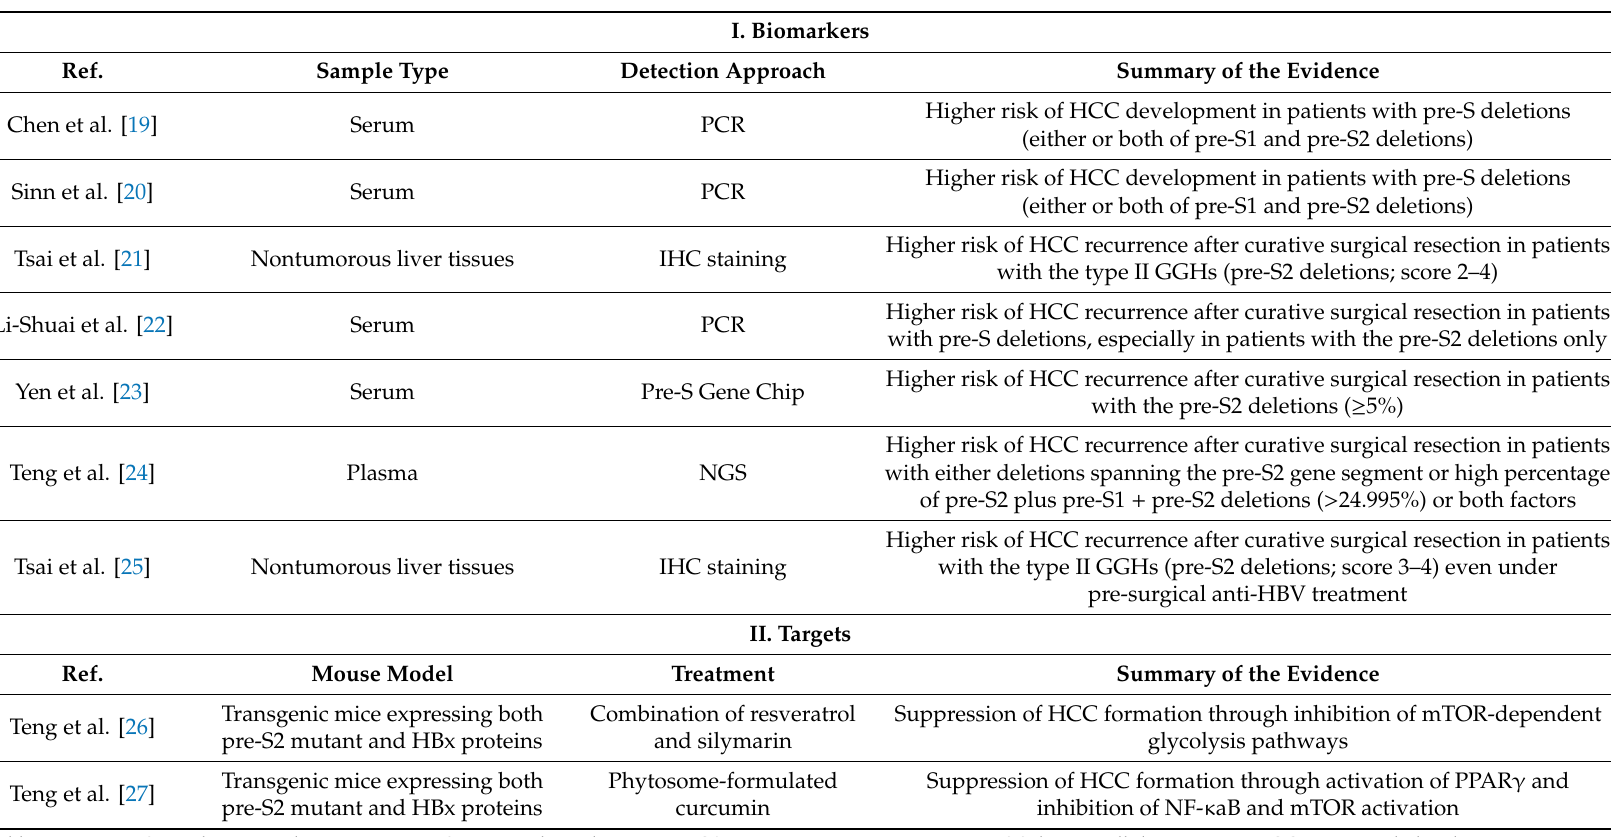
Table 1. The roles of pre-S mutants as biomarkers and targets for hepatitis B virus (HBV)-related hepatocellular carcinoma (HCC) development and recurrence. I.